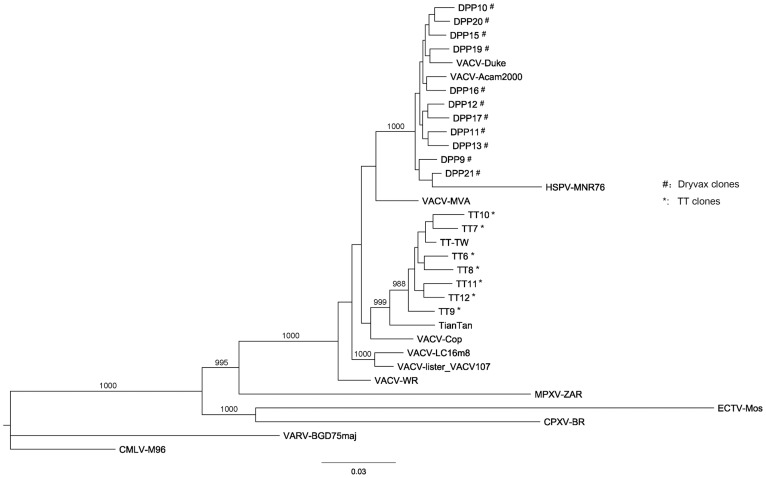
Phylogenetic analysis of TT and other OPV strains.Phylogenetic relationships between TT-associated strains (including Tian Tan and TT-TW), TT clones (marked by *), and OPVs including 11 Dryvax clones (marked by #). Bootstrap values higher than 900 are shown. Names and GenBank accession numbers of the viral strains shown in this figure are listed in Table S1. The scale bar of branch length was shown under the phylogenetic tree.